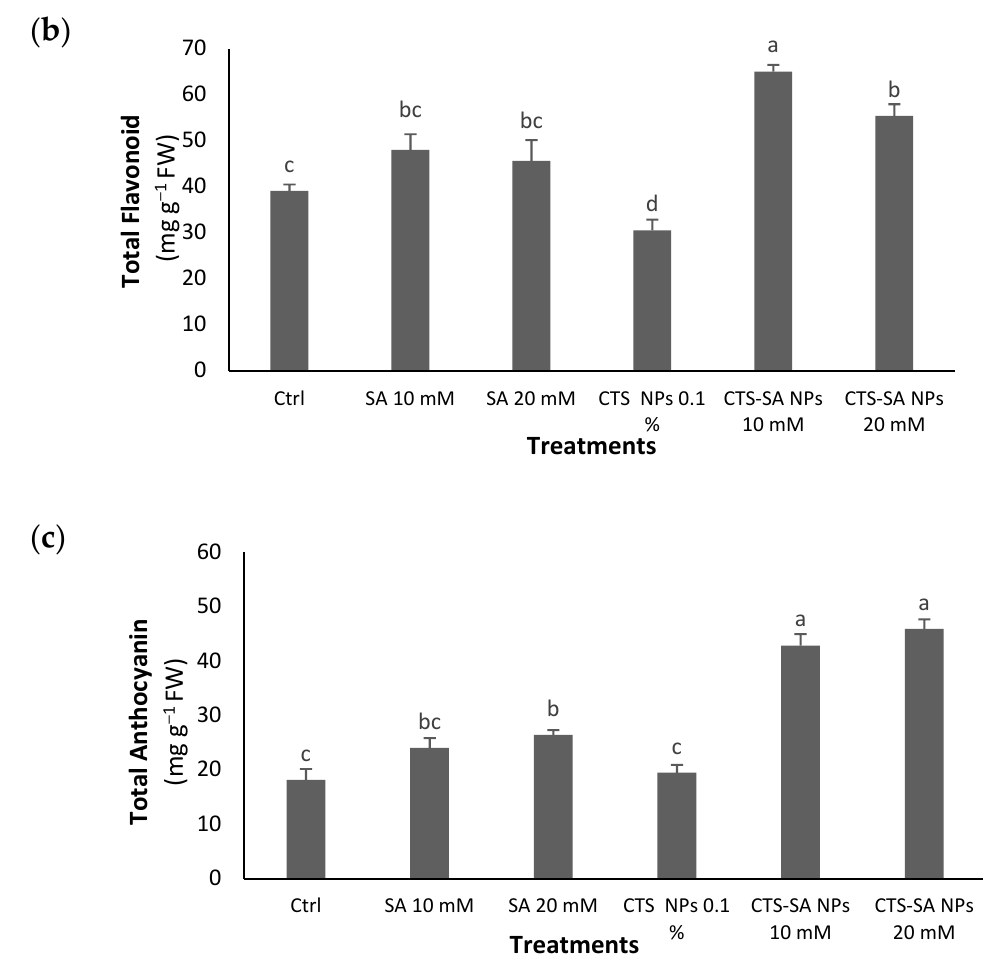
Figure 3. The effect of salicylic acid (SA) (10 and 20 mM), chitosan (CTS) (0.1%), and their combination in nano-form (CTS-SA NPs) treatments on the total phenolic compounds ( a ), flavonoids ( b ), and total anthocyanin ( c ) contents of grape ( Vitis vinifera L.) cv. Red Sultana. Different letters indicate significantly different values at p ≤ 0.05.